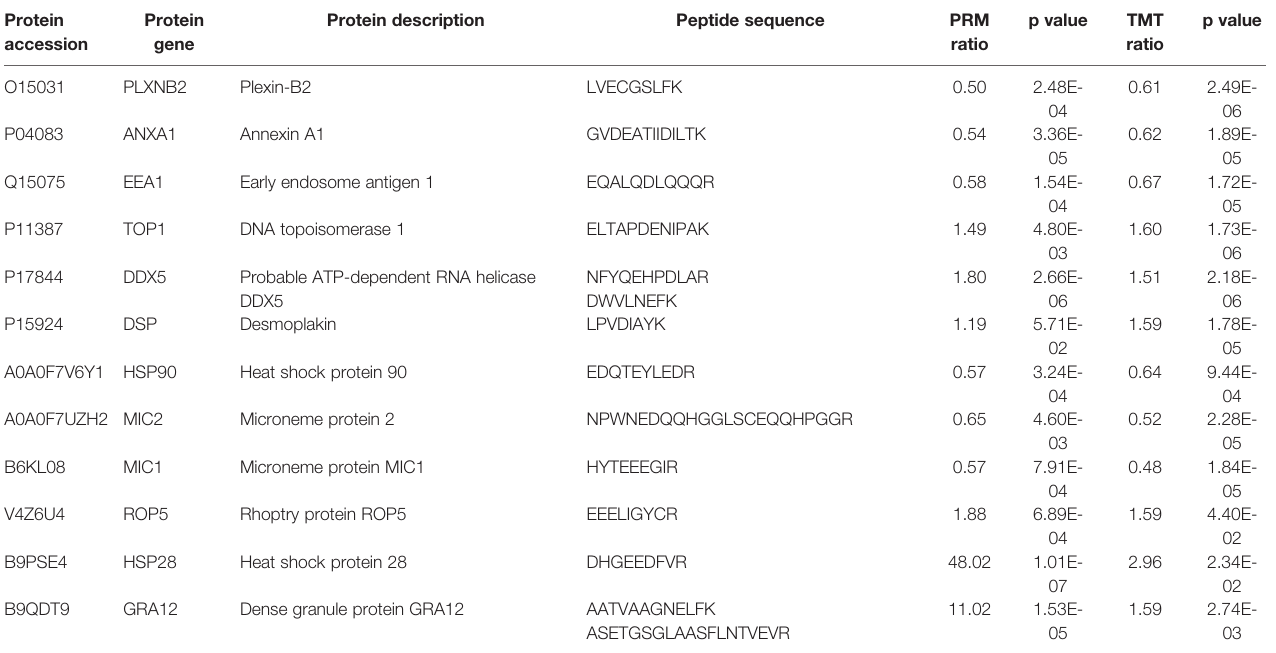
TABLE 2 | Comparison of the quanti fi cation results of TMT analysis and PRM assay of candidate DEPs in the HT vs . H and HT vs . T groups. Protein Protein accession